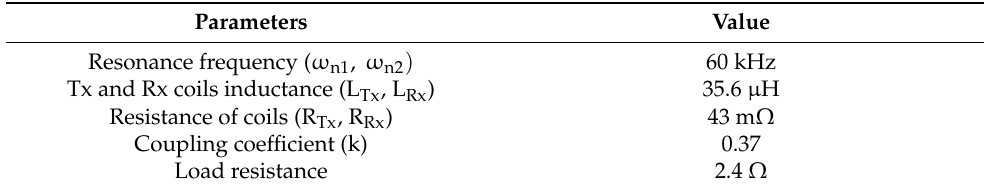
Table 6. Setup for circuit simulation of changing input impedance according to L add .